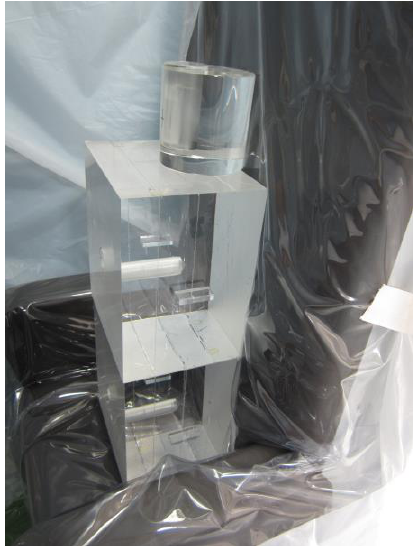
Figure 2. Thyroid phantom on the acrylic block phantoms.